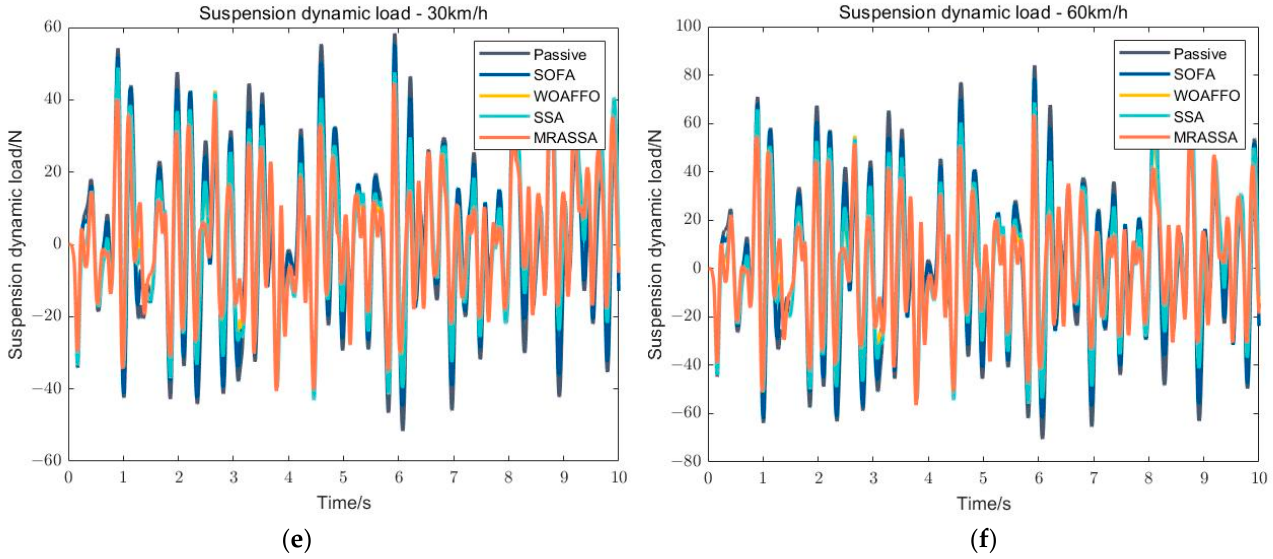
Figure 10. Suspension performance at the random road in the simulation. ( a ) Suspension acceleration at 30 km/h; ( b ) Suspension acceleration at 60 km/h; ( c ) Suspension displacement at 30 km/h; ( d ) Suspension displacement at 60 km/h; ( e ) Suspension dynamic load at 30 km/h; ( f ) Suspension dynamic load at 60 km/h.